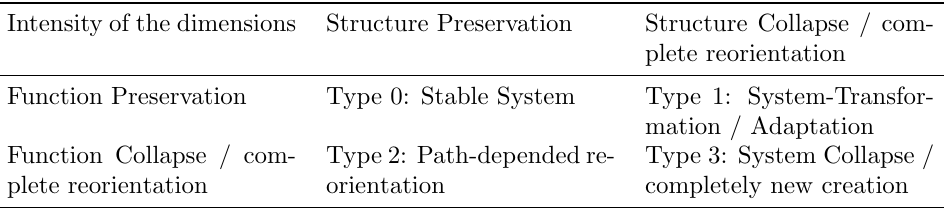
Table 2: Typology of change processes in relation to the preservation or collapse of structure and